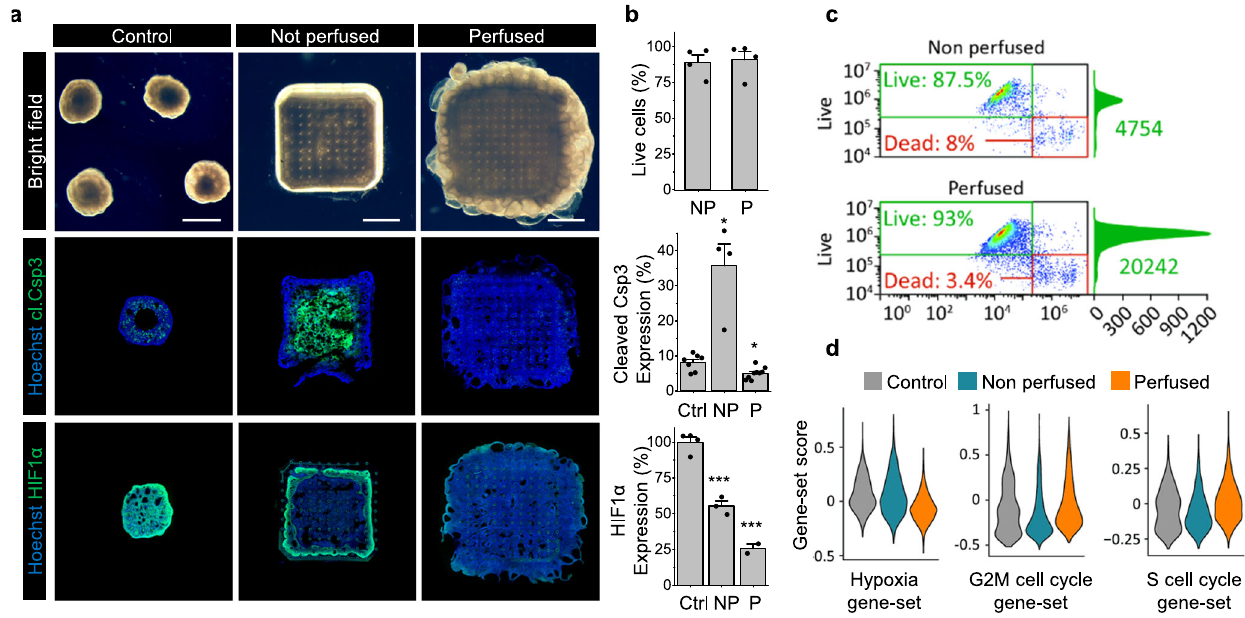
Fig. 3 | Changesin proliferationmediatedbyhypoxia. a Representative samples demonstratingdifferencesinproliferationandviabilitybetweenstandardorganoid culture (left column) and the tissue constructs without (middle column) and with perfusion (right column). Top row: bright fi eld images of organoids, non-perfused and perfused constructs. Middle row: immuno fl uorescent images of apoptotic marker cleaved Caspase 3 (green) expressed in the three conditions. Bottom row: immuno fl uorescent images of hypoxia marker HIF1 α (green). Hoechst staining of nuclei shown in blue. The images represent transverse cross-sections of the tissue constructs. The statistics on the biological replicates is given in b . Scale bar 1mm. b Top:averageproportionofthenumberoflivecellsinperfusedandnon-perfused constructs quanti fi ed by fl ow cytometry (90.9±5.1% in perfused vs 89.2±4.4% in non-perfusedtissue,n.s., n =4).Middle:averageexpressionofcleavedCaspase3in controlorganoids(8±1%area, n =7),non-perfused(35.7±5%,p Control =0.02, n =4)